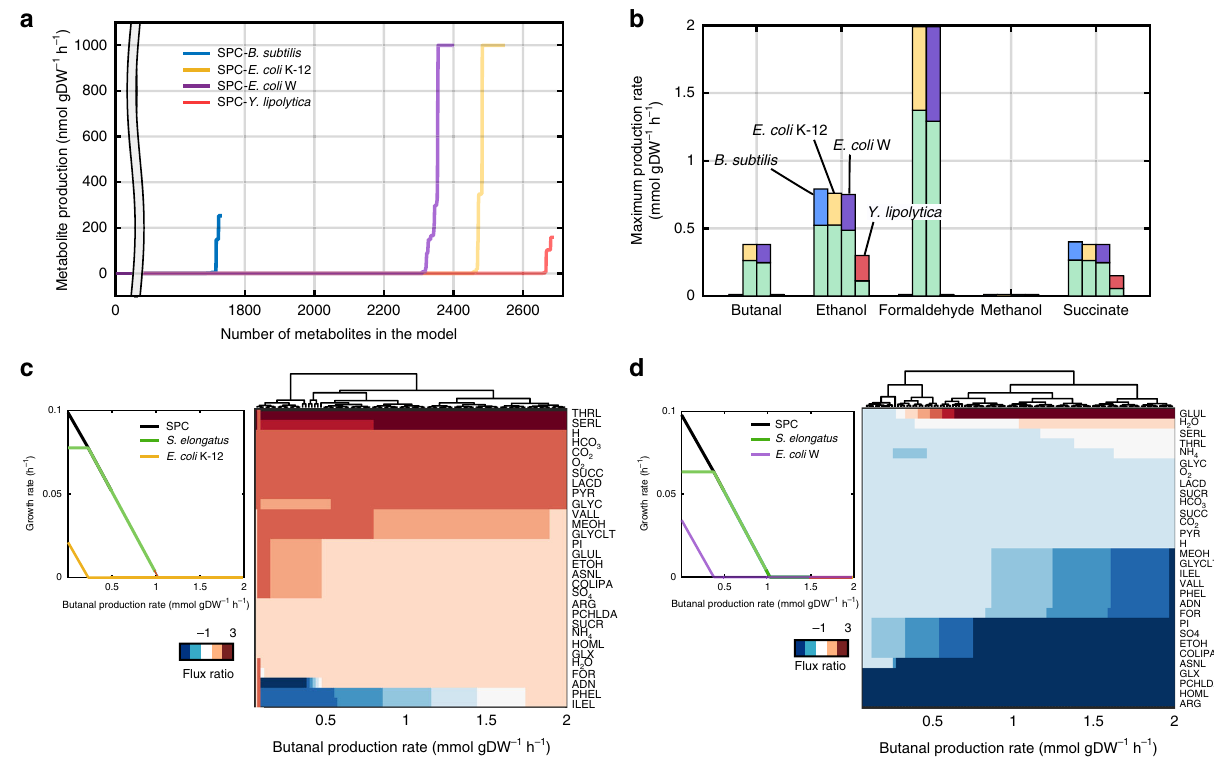
Fig. 2 Organic chemical production by synthetic phototrophic communities. a Production capabilities were evaluated for all SPCs by iteratively simulating the synthesis of metabolites while maximizing for growth. Metabolite production rates were sorted and plotted for each synthetic phototrophic community (SPC). Metabolites feasible to produce were identi fi ed by having production rates over 1 × 10 − 2 mmol gDW − 1 h − 1 . b Overall production capabilities for butanal, ethanol, formaldehyde, methanol, and succinate. The bar plot shows the predicted maximum production rate achieved by each SPC. The predicted abundance (growth rate) of community members is shown for S. elongatus cscB + (green) and for heterotrophs (blue B. subtilis , yellow E. coli K-12, purple E. coli W, or pink Y. lipolytica ). Microbial communities containing E. coli strains showed high formaldehyde production potential. c , d Predicted growth rates and associated metabolic exchanges for the SPC composed of S. elongatus cscB + and either E. coli K-12 ( c ) or E. coli W ( d ) while producing butanal. CM- models enable prediction of substrate resource allocation into growth or into target metabolites. Production of metabolites reduces the growth of community members as observed in the growth rate plots. Here, the overall growth rate of the community (black line) and each member (green S. elongatus cscB + paired with yellow or purple for E. coli K-12 or E. coli W, respectively) were simulated. Simulations show that at higher butanal production rates the heterotroph will be outcompeted by the phototroph before the SPC crashes. The complete-linkage clustering based on the metabolic exchange predictions shows associations among metabolites listed on the y -axis and butanal production rates from left to right. Growth rate predictions were remarkably associated with a speci fi c metabolic exchange. For example, the synthesis of butanal by the E. coli K-12 SPC was possible by increasing the fl ux exchange of metabolites such as isoleucine (ILEL), phenylalanine (PHEL), serine (SERL), and threonine (THRL), while for the E. coli W SPC